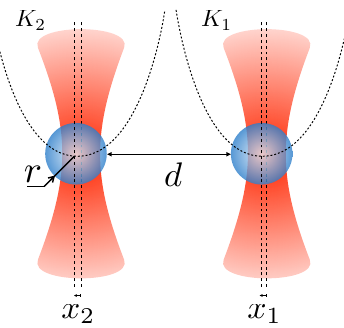
Figure 1: Two Brownian particles trapped by optical tweezers into two harmonic potentials of stiffness K relative to the trap center x 0 absolute position. d is the mean distance to contact between the two particles of radius r = 1 µ m: d = | x 0